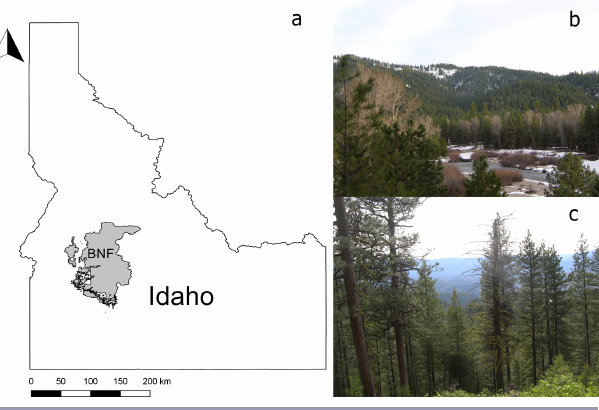
Fig. 1 . Location of (a) the Boise National Forest (BNF) within Idaho, USA, and typical landcover (b and c) where surveys for nocturnal owls and diurnal woodpeckers were conducted during